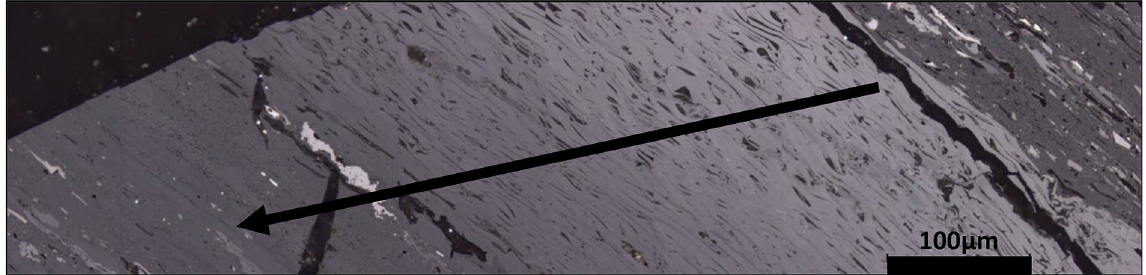
Fig. 7 Mosaic photomicrograph showing fusinite (right; well-preserved structure, high reflectance) grading into semifusinite (structured still, lower reflectance), and finally into vitrinite (bottom left; unstructured, lowest reflectance) observed in the inertinite-rich sample. 9 500 magnification, reflected light under oil immersion. Scale is indicated